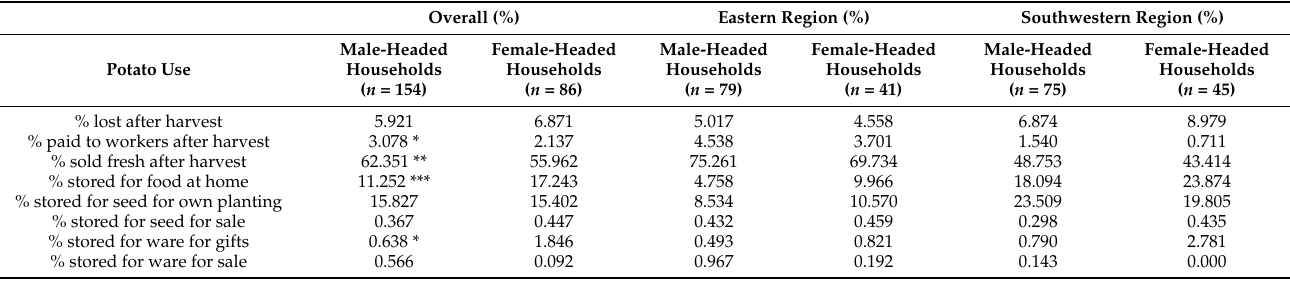
Table 5. Use of harvested potato by